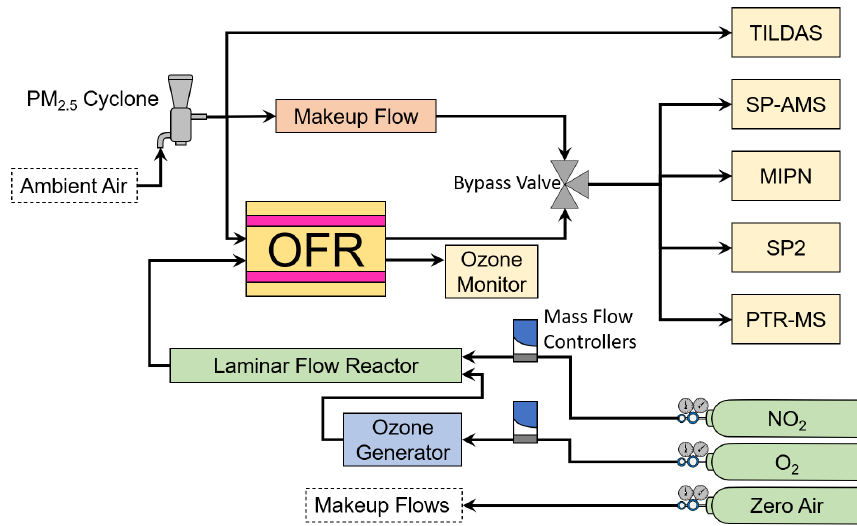
Figure 4. A schematic of the general experimental setup aboard the AML showing instruments, reactors, reagents, and other hardware.